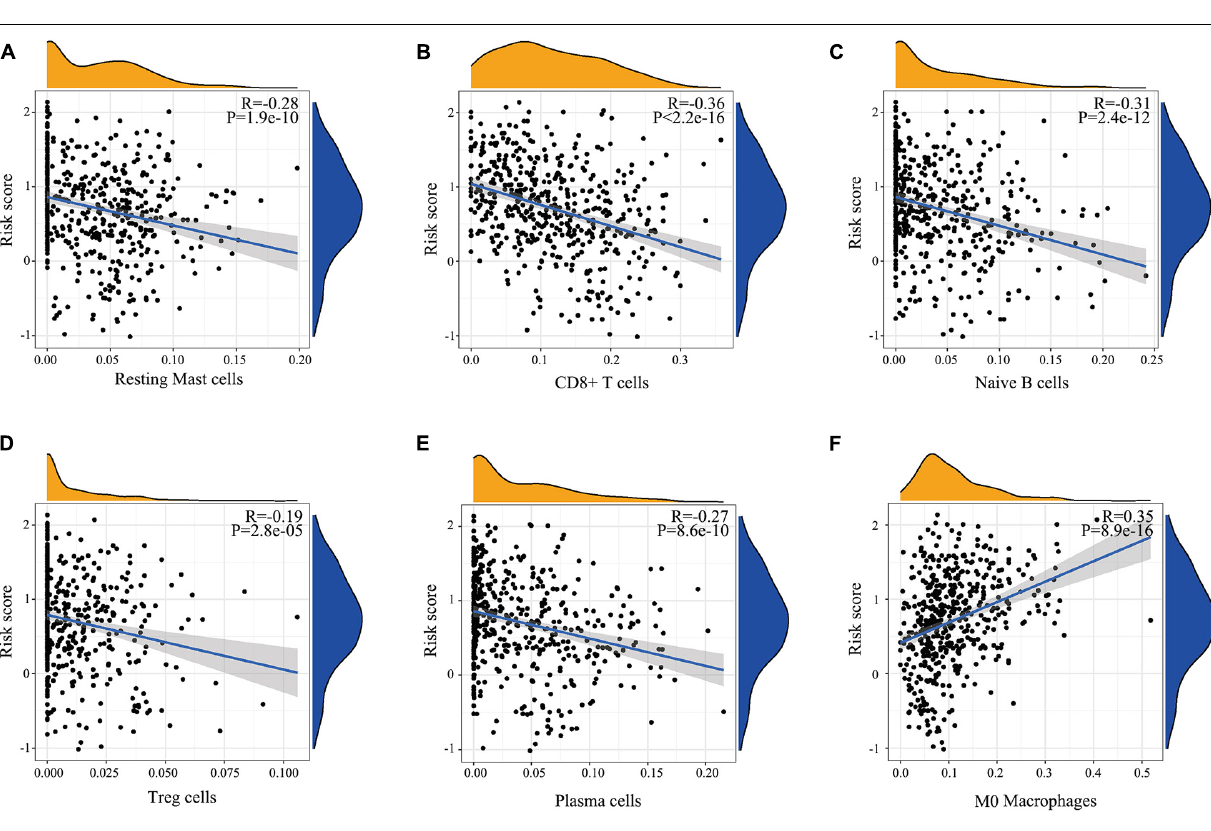
Frontiers in Genetics |